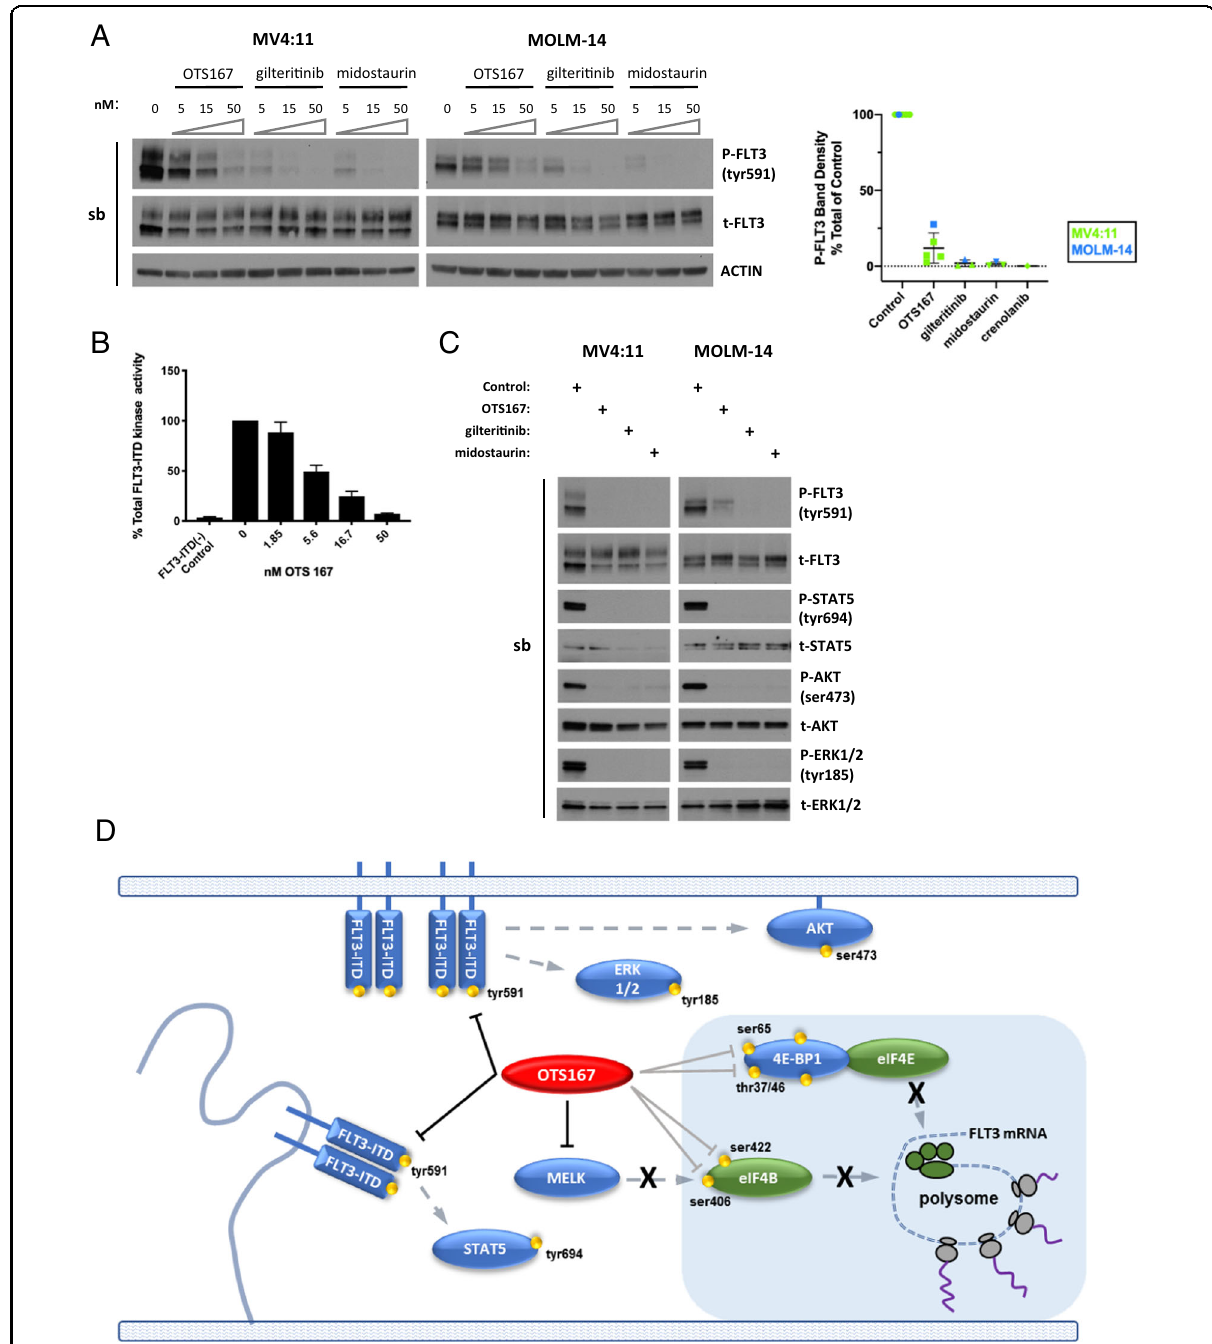
Fig. 4 OTS167 inhibits FLT3 phosphorylation and signaling in FLT3 mutant cell lines. A Western Blot analysis of P-FLT3 in MV4:11 or MOLM-14 after treatment with indicated concentrations of OTS167, gilteritinib, or midostaurin for 2 h. (7 biological replicates)(single blot). B In vitro kinase assay of FLT3-ITD recombinant protein with increasing concentrations of OTS167. (1 biological replicate; 3 technical replicates). C Western Blot analysis of P- STAT5, P-AKT, or P-ERK1/2 in MV4:11 or MOLM-14 after treatment with 50 nM OTS167, 50 nM gilteritinib, or 50 nM midostaurin for 2 h. (6 biological replicates)(single blot stripped and re-probed for total protein detection). D Schematic of signaling pathways inhibited by OTS167. Black blocking lines represent direct kinase inhibition. Gray blocking lines represent inhibition of downstream phosphorylation events. Dashed arrows represent signaling